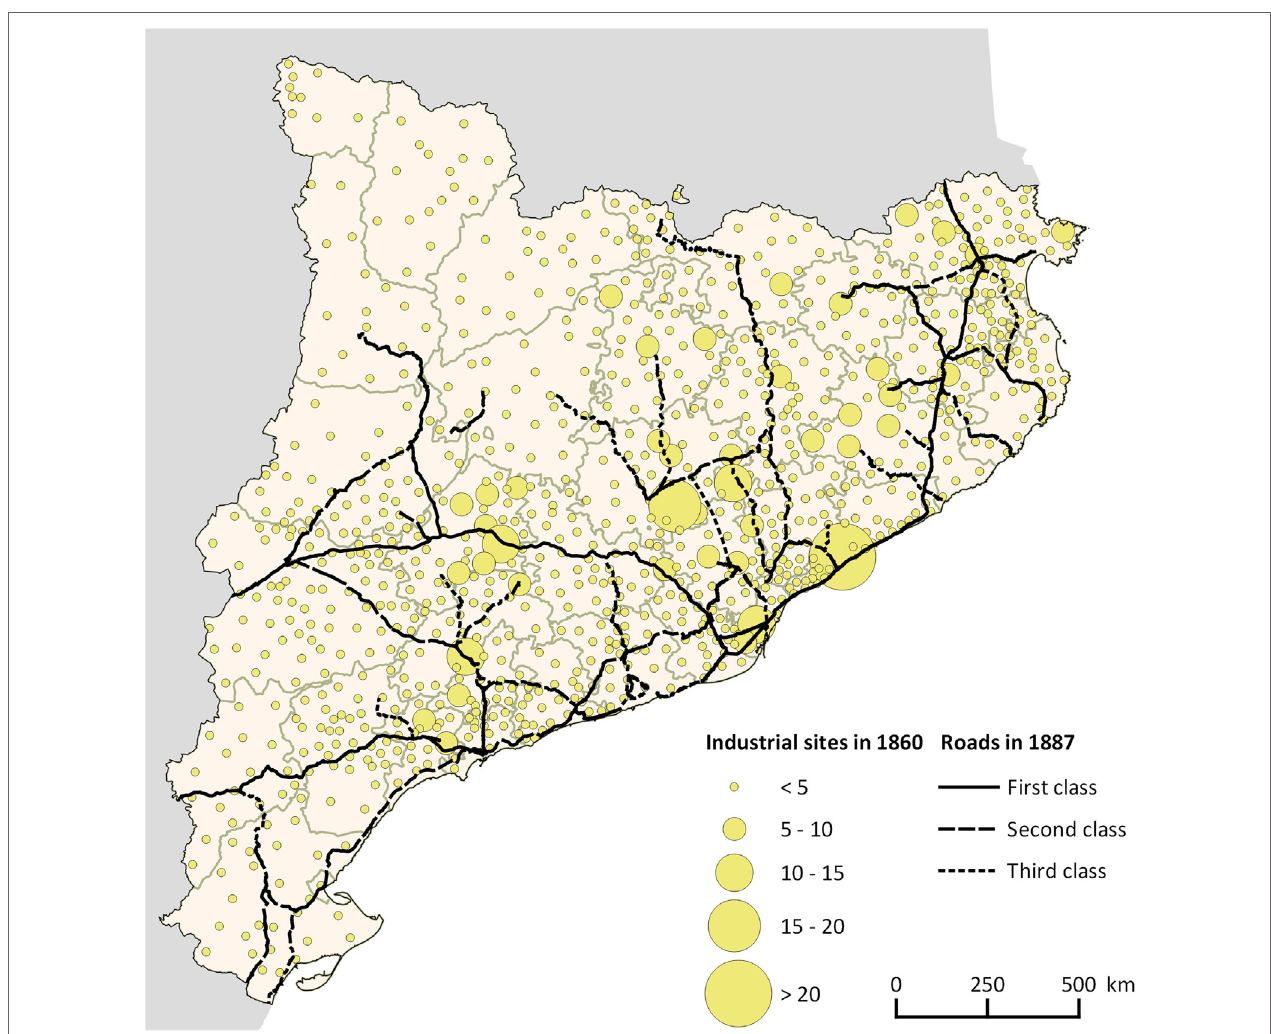
FigUre 9 | Heritage sites and roads in Catalonia in 1860. Source: Own